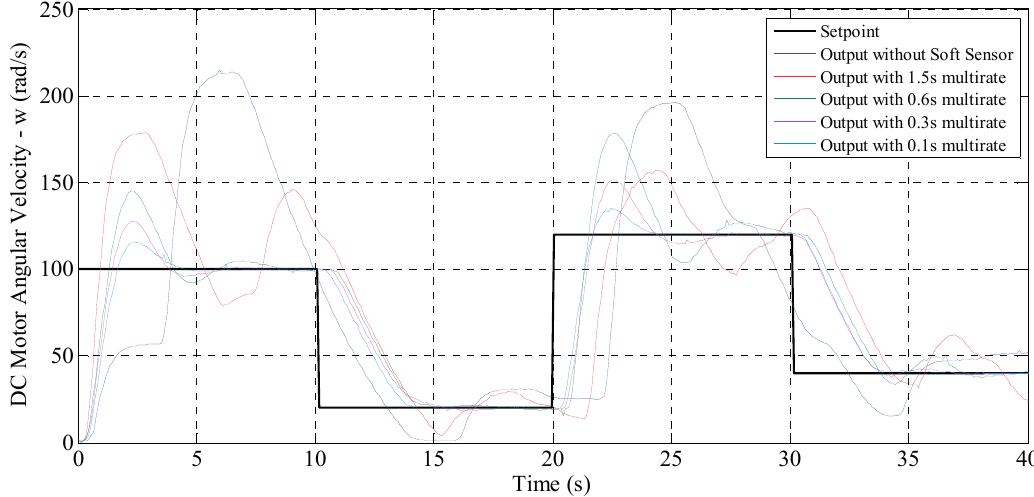
Figure 7. Comparison between the WNCS responses: wireless sensor with real sampling period of 3 s and soft sensor with virtual data sampling period of 1.5, 0.6, 0.3 and 0.1